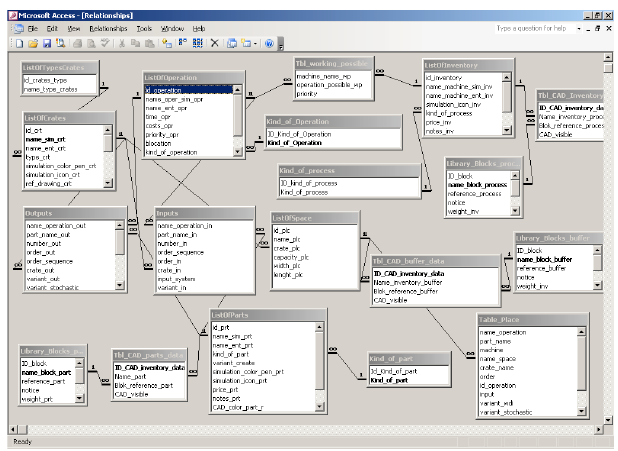
Fig. 5. Snapshot from MS Access relational database